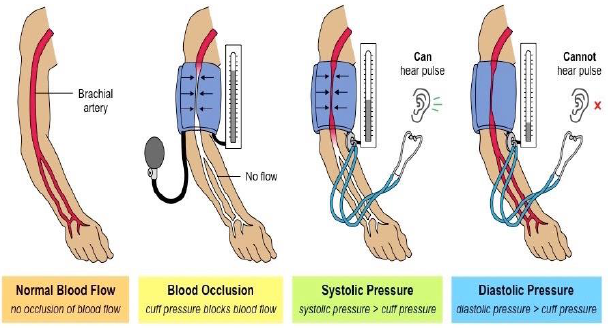
Figure 7. Systolic and diastolic blood pressure (BP) measurement using cuff [101].